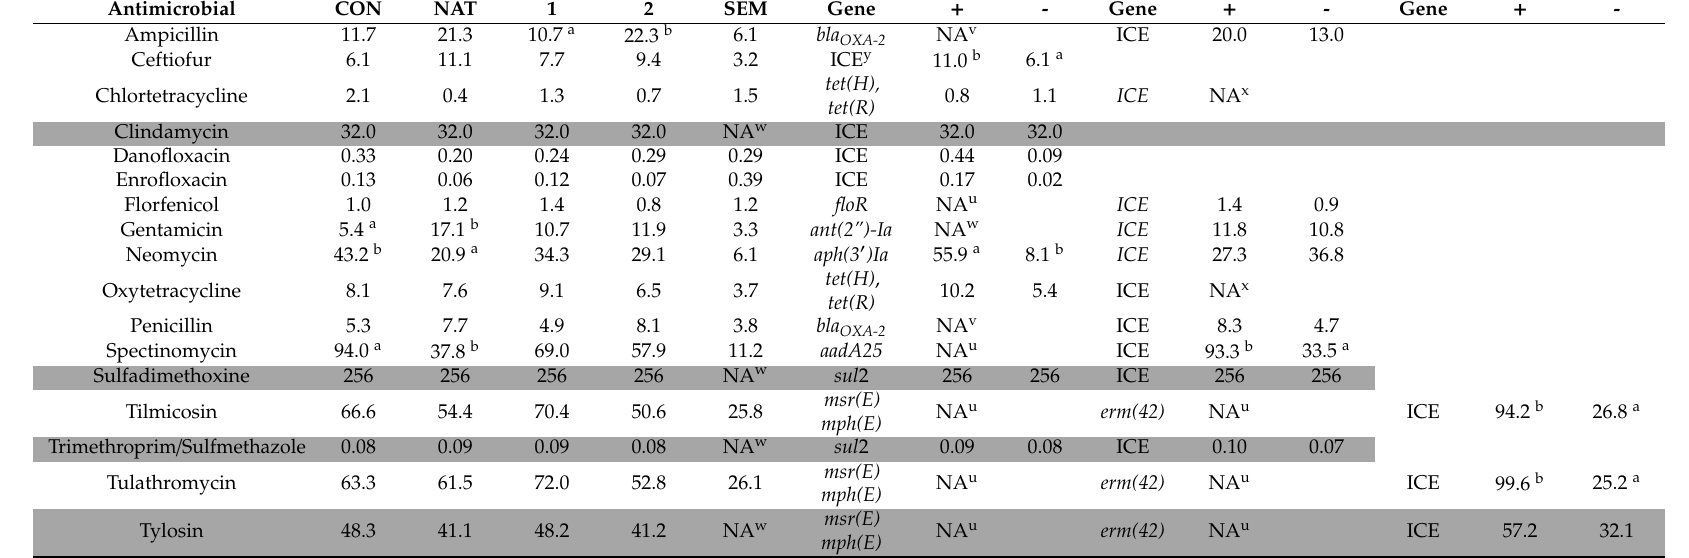
Table 6. E ff ect of management z , year of study and presence of ICE core and antimicrobial resistance genes on of minimum inhibitory concentrations (MICs) for P. multocida ( n = 45). Least square means are reported for antimicrobials showing unimodal distributions (unshaded) and arithmetic means for other distributions (shaded in dark grey). MICs < or > than the range of concentrations evaluated were estimated as the next lower or higher concentration commonly used on the Sensititre plate.